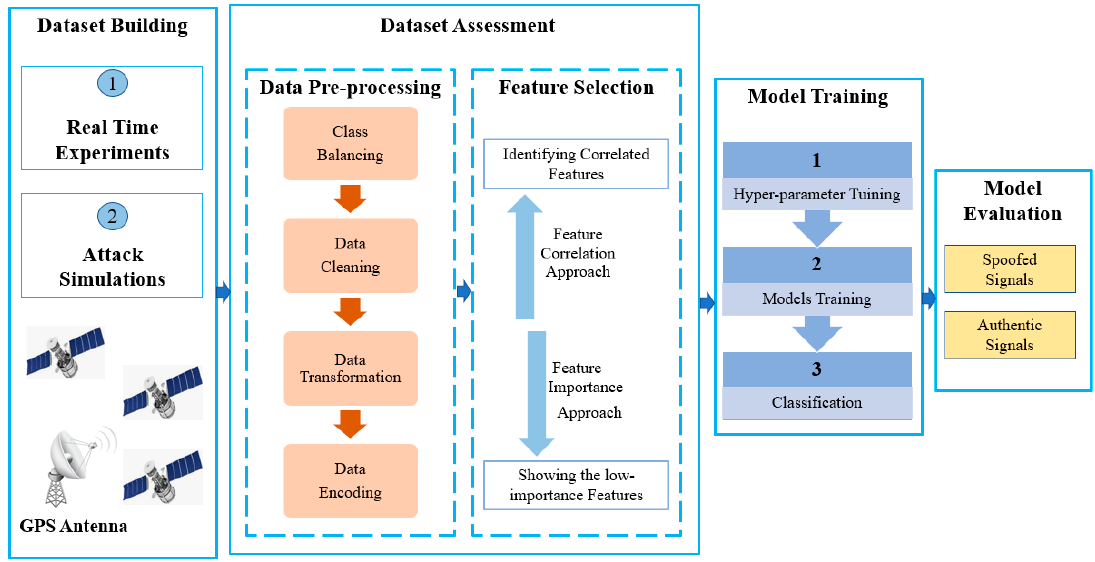
Figure 2. Process to study the impact of dataset characteristics and model parameters on GPS spoofing detection systems.